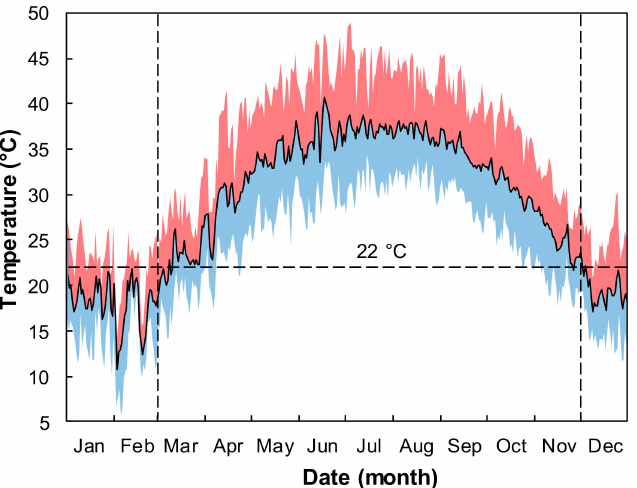
Figure 8. Measured daily air temperature in Doha, Qatar. The black line represents the average daily temperature, and the red and blue shaded areas are bounded by the maximum and minimum daily temperatures,